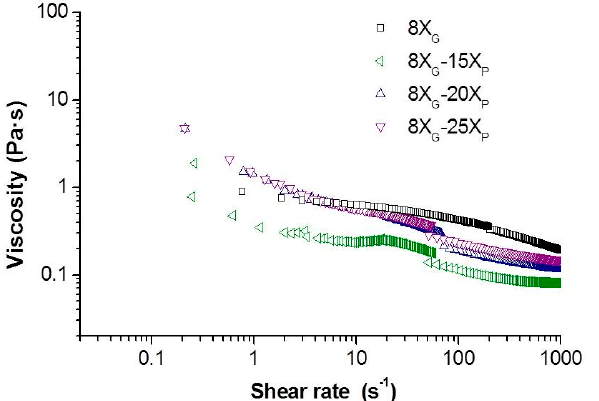
Figure 4. Evolution of the viscosity with the shear rate of 50 vol.% Ti slurries with 15, 20 and 25 wt.% of ammonium bicarbonate and 12g/L of MC.